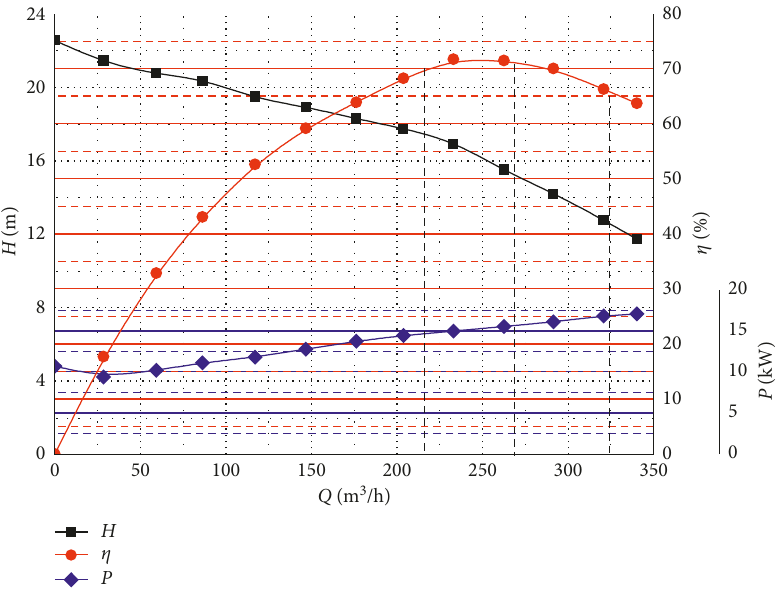
Figure 4: Energy performance curve of the centrifugal pump with vaned diffuser.